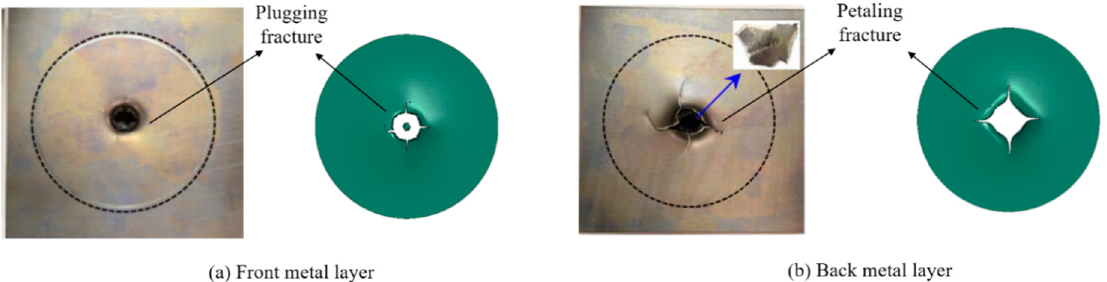
Figure 10. Perforated damage surface of the Titanium layer.